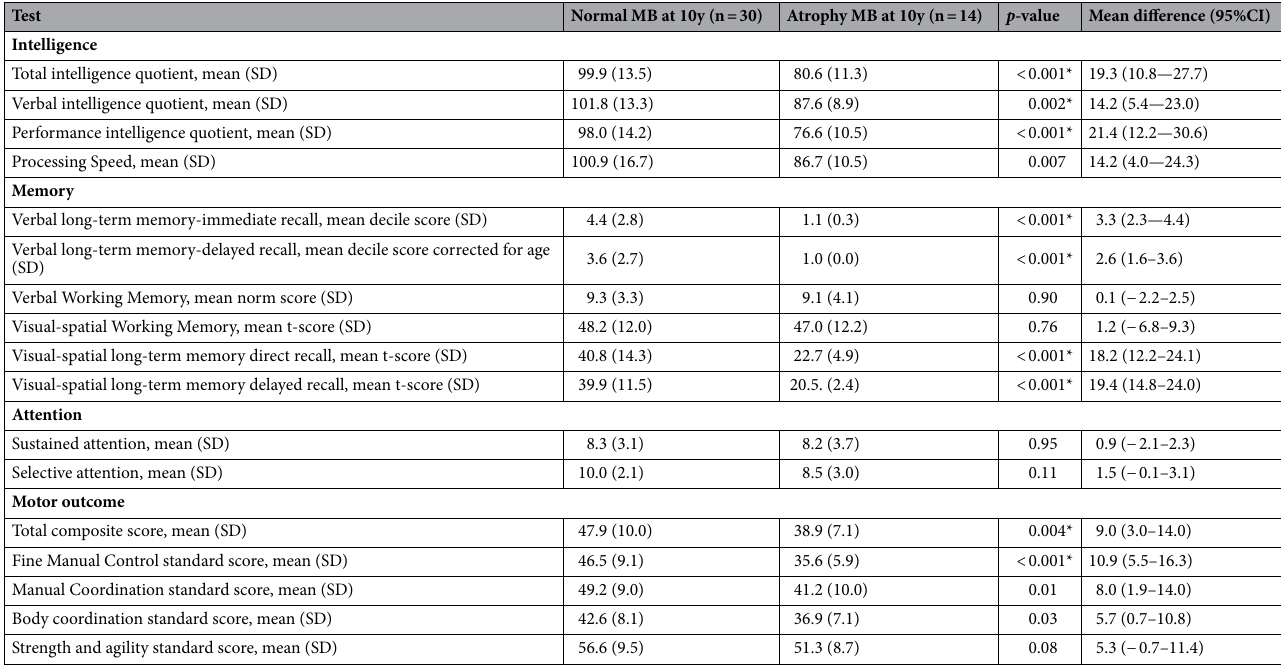
Table 3. Neurodevelopmental outcome and MB at follow-up. *For the outcomes of the neuropsychological assessments, after correction for multiple comparison, p -values < 0.004 were statistically significant. For the motor outcome, p -values < 0.01 were statistically